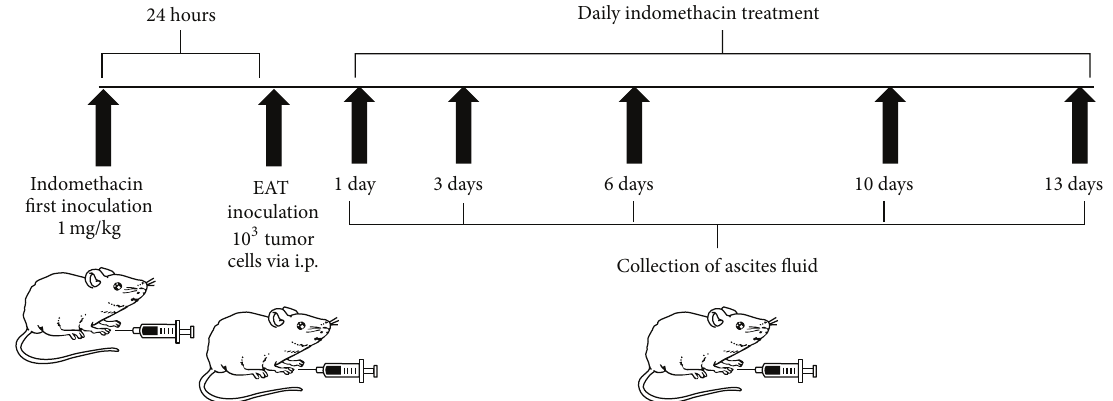
Figure 1: Study setting and time period. To assess the involvement of prostaglandin in cytokines profile during growth of EAT, mice were inoculated with 1000 tumor cells intraperitoneally (i.p.) and received indomethacin at a dose of 1mg/kg, once a day, via i.p. The first dose of indomethacin was administered 24 hours prior to tumor implantation. After 1, 3, 6, 10, and 13 days the animals were euthanized and evaluated for cytokine profile.